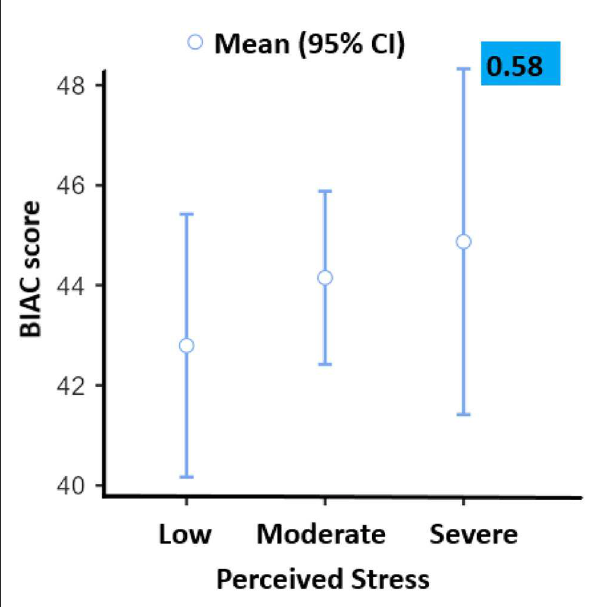
FIGURE2 BIAC scores vs. stress levels. CI, confidence interval.